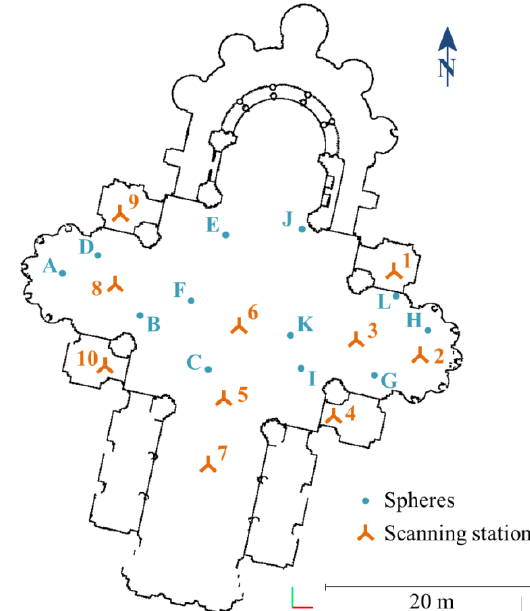
Figure 3. Overview of the distribution of the scanning stations and of the registration targets